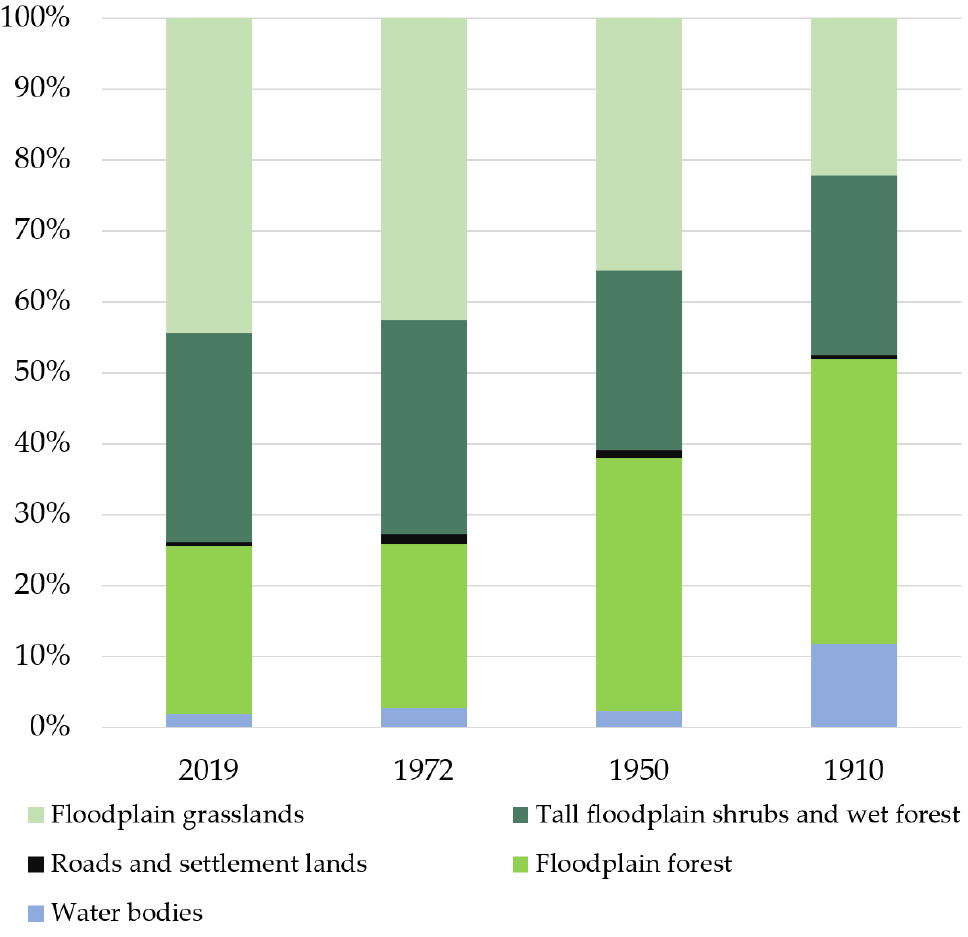
Figure 5. Dynamics of natural–territorial complexes of site in vicinity of village of Kaibasovo.